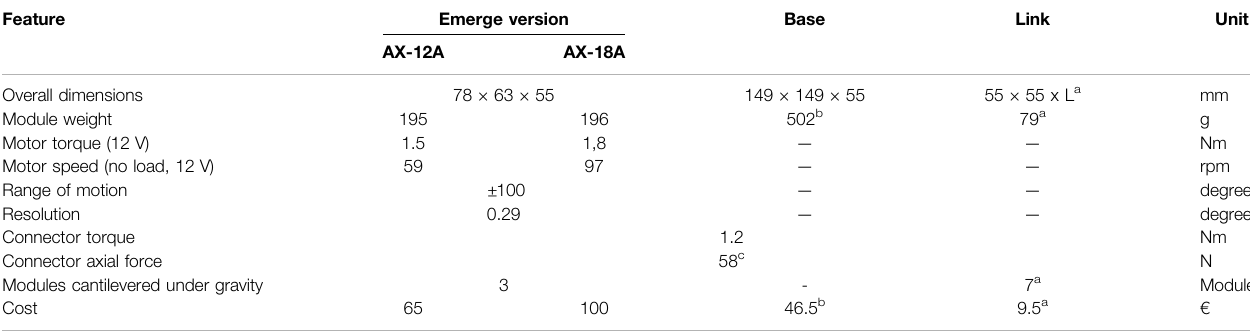
TABLE 1 | Main features of the EMERGE module.